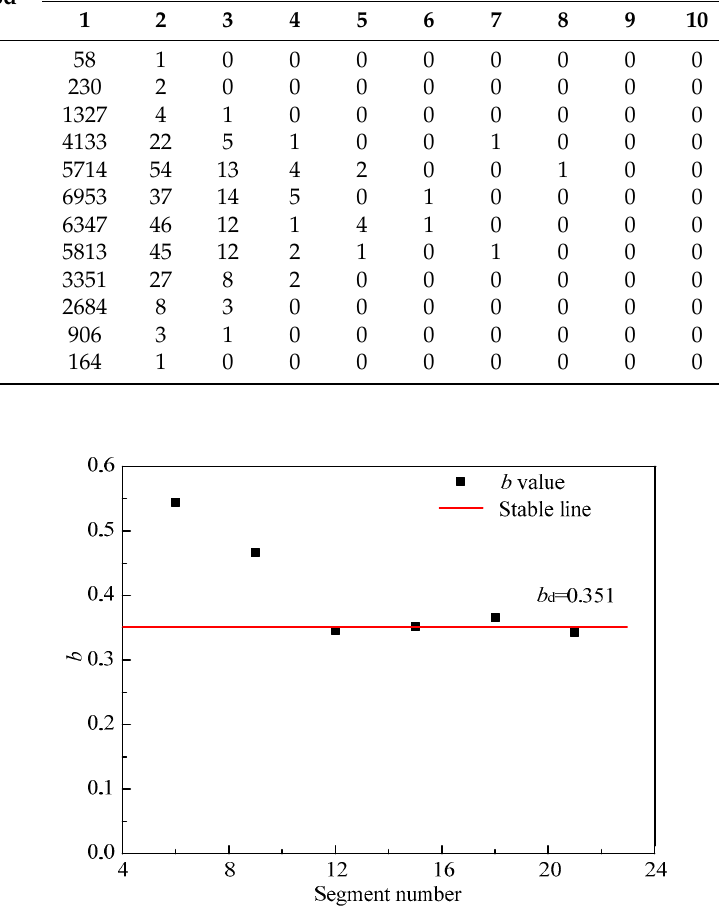
Figure 7. Determination of the b d value of mortar specimen with sandwich iron.